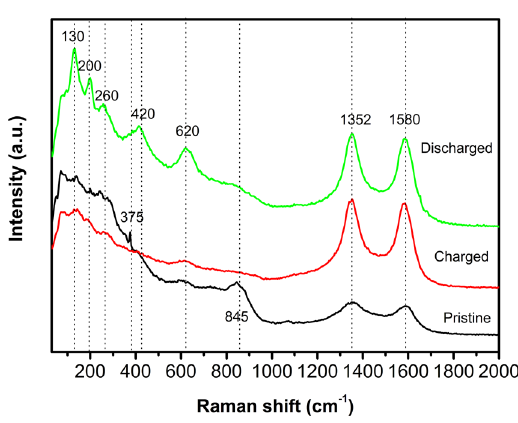
Figure 5. Raman spectra of pristine, charged and discharged Na 2 Ti 0.94 Cr 0.06 O 2.97